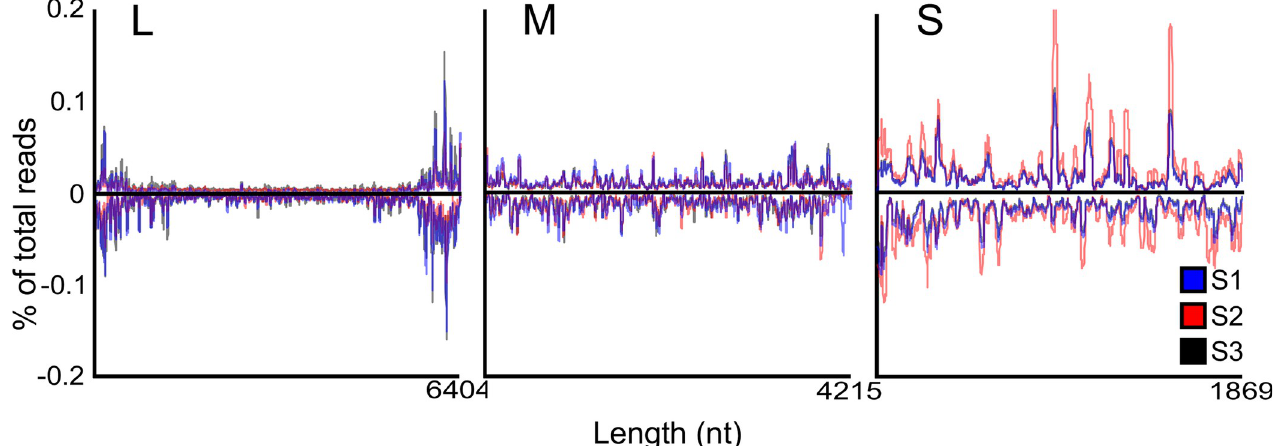
Fig 9. The distribution of 21 nt vsiRNA reads mapped to rTOSV segments. Graphs show the distribution by genomic coverage of 21 nt vsiRNAs along each rTOSV segment length, normalised as a percentage of total reads, per replicate as indicated by colour. Read numbers mapping genome sense are indicated by (-) and antigenome by (+).